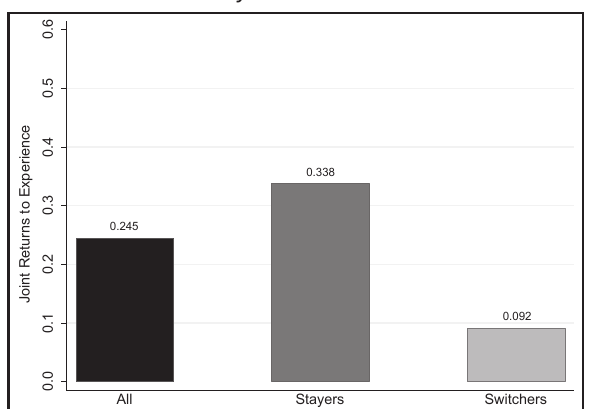
Returns to source country experience for the average immigrant – two-digit level. Returns for “All workers” are significant at the 1% level, returns for “Stayers” are significant at the 10% level, and returns for the Switchers sample are not signifi- cant at any of the conventional